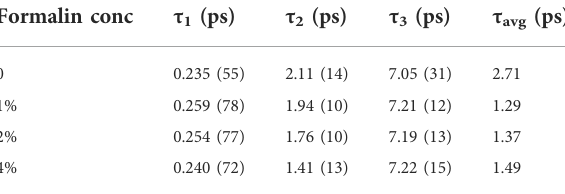
TABLE3 Fluorescence lifetimes ofANSin a -Chymotrypsininpresence of formalin. Formalin